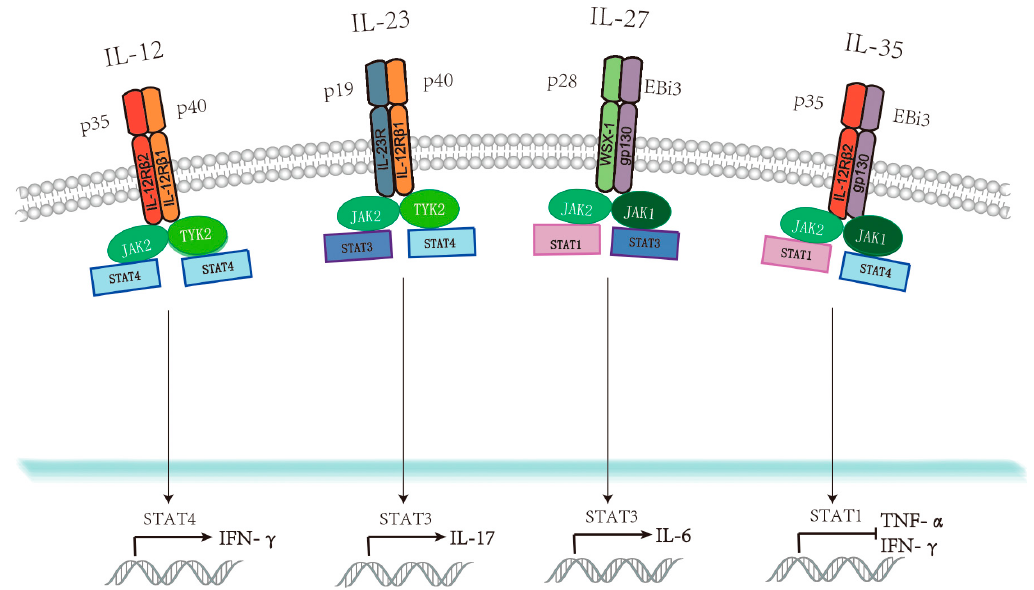
Figure1. Interleukin12(IL-12)familymembers, correspondingreceptors, andregulationofdownstream signaling Figure 1. Interleukin 12 (IL-12) family members, corresponding receptors, and regulation of downstream signaling pathways.